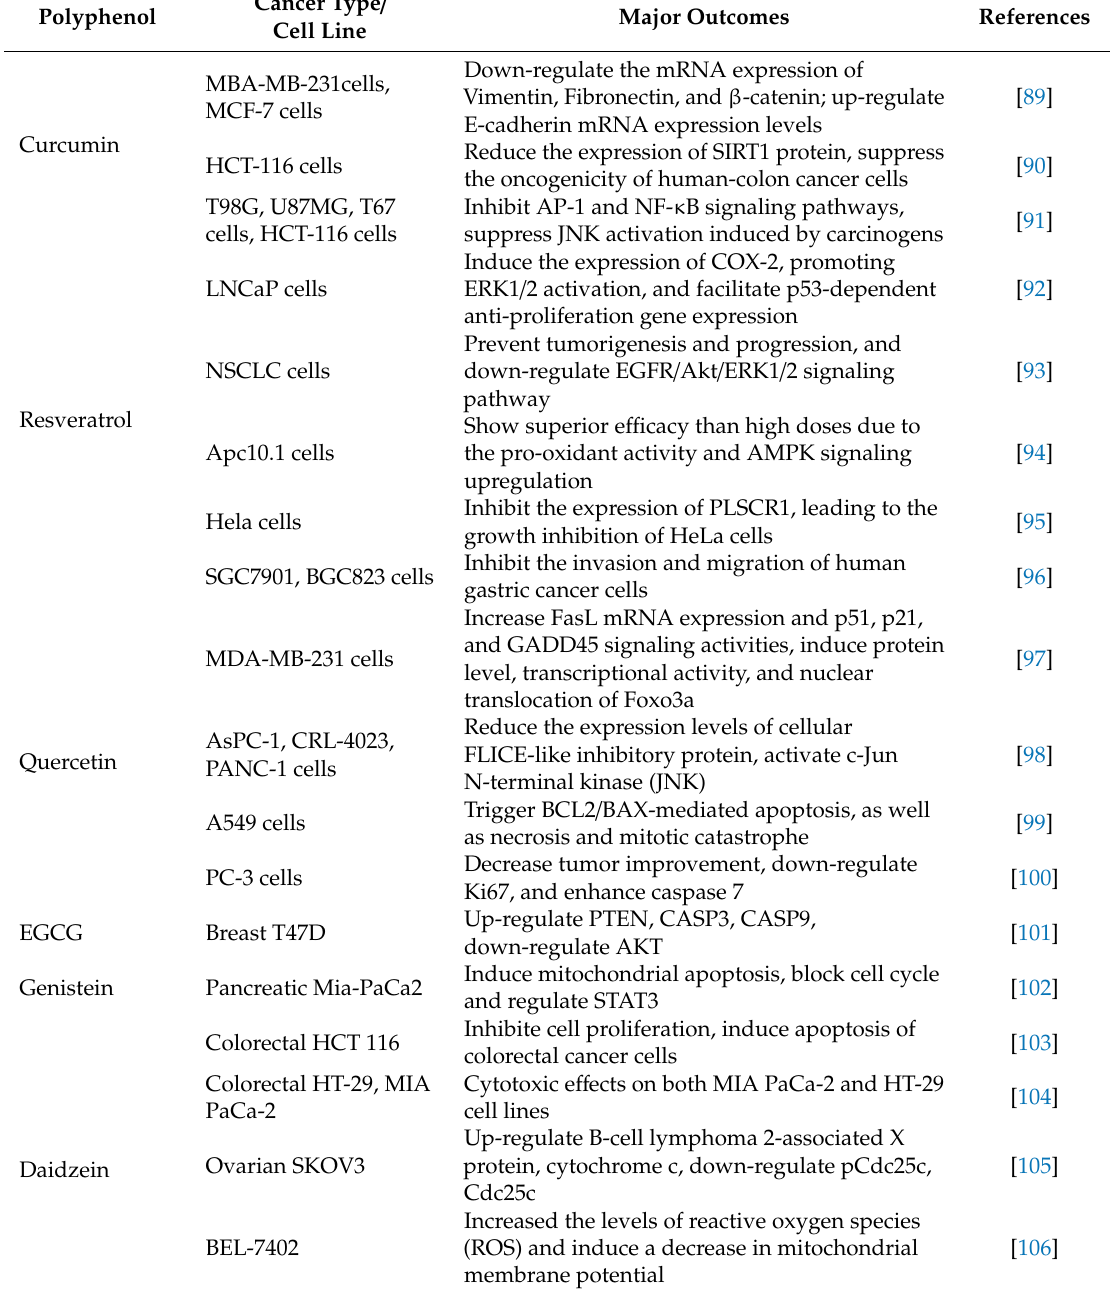
Table 2. Anti-cancer e ff ects of some